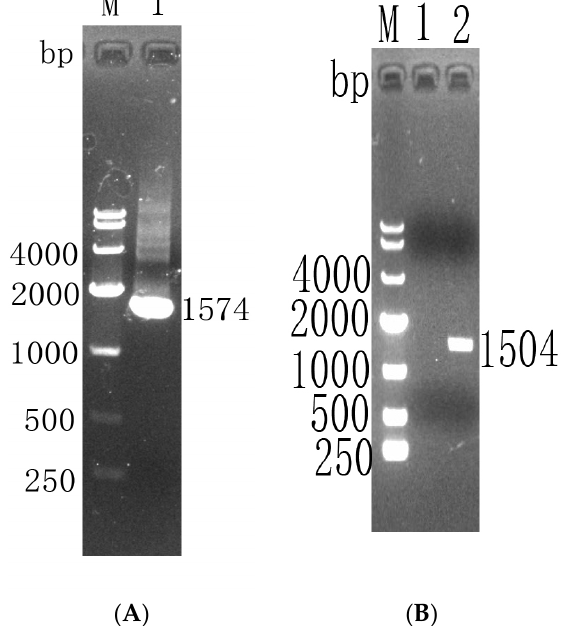
Figure 1. Cloning of the LsSox 2 and LsSox 9 genes of Lutraria sieboldii . ( A ) Cloning of the LsSox 2 gene, M: DL10000 DNA marker, 1 LsSox 2: amplification product. ( B ) Cloning of the LsSox 9 gene, M: DL10000 DNA marker, 1: water, 2: LsSox 9 amplification product.